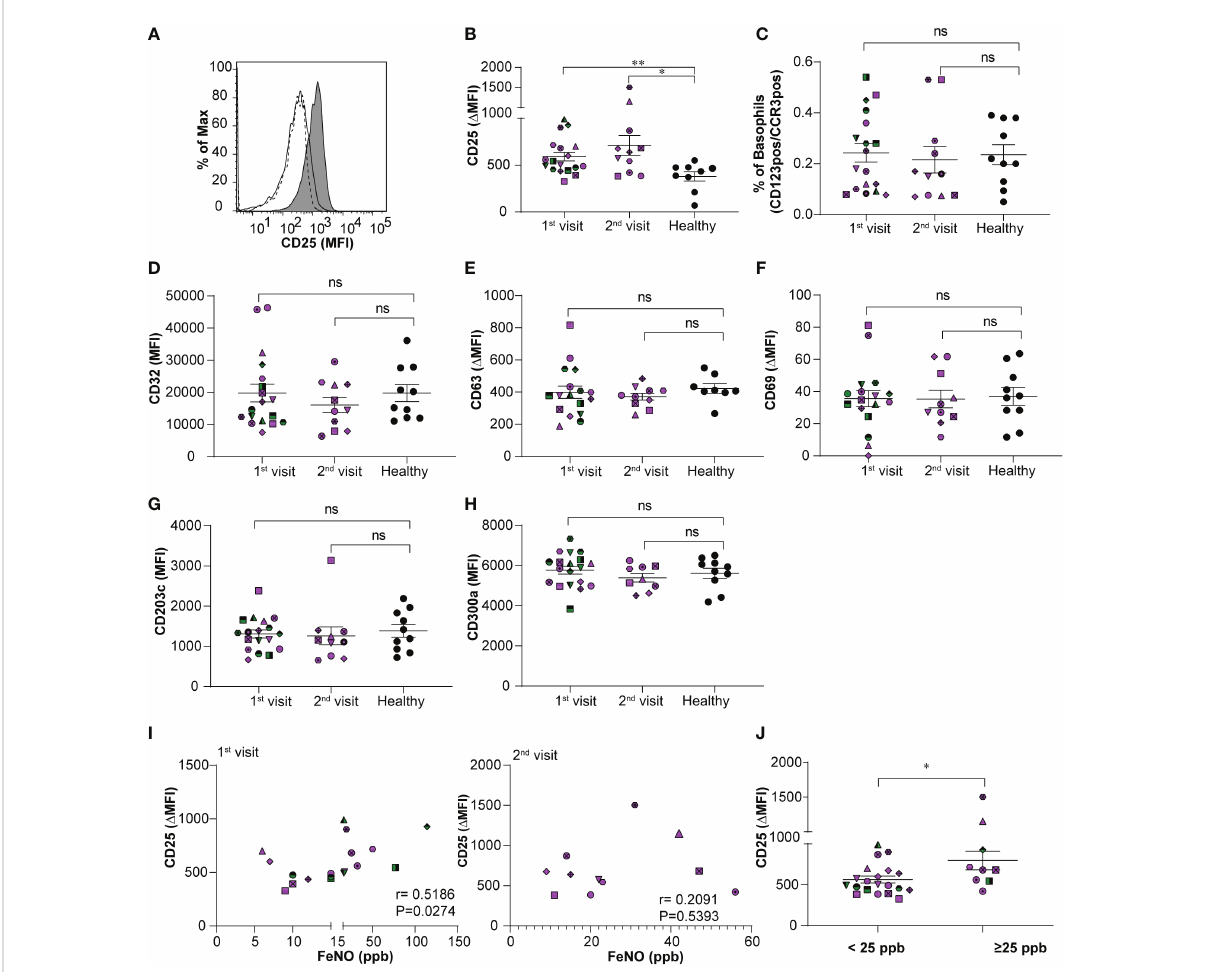
FIGURE 1 Relationship between expression levels of CD25 on basophils and FeNO levels in stable-mildly symptomatic allergic asthma patients. (A) Representative histogram showing CD25 expression level (MFI) on blood basophils in stable-mildly symptomatic allergic asthma patient (gray area) compared to healthy control (solid line) and FMO control (dotted line). (B, D-H) The expression levels of surface markers on blood basophils of stable-mildly symptomatic allergic asthma patients for the fi rst (n=18) and second visit (n ≤ 11) compared to healthy controls (n ≥ 9) measured by fl ow cytometry. Data are represented as mean ± SEM and reported as D MFI (MFI of test-MFI of FMO control) for CD25, CD63, CD69 and as MFI for CD32, CD203c and CD300a. Results were analyzed by two-tailed unpaired Mann-Whitney test.**P=0.0065, *P=0.0159, ns=non-signi fi cant (C) The relative percentage of blood basophils (dual positive for CD123 and CCR3) from stable-mildly symptomatic allergic asthma patients during their fi rst (n=18) and second (n=11) visits compared to healthy subjects (n=10) (I) Correlation between CD25 expression levels ( D MFI) and FeNO levels (ppb) in stable-mildly symptomatic allergic asthma patients of the fi rst (left, n=18) and second visit (right, n=11). Spearman`s rank test was used for correlation analysis. Spearman coef fi cient (r) and level of signi fi cance (P) are indicated within the graph. (J) Surface expression levels of CD25 ( D MFI) on blood basophils between <25 ppb (n=20) and ≥ 25 ppb FeNO level (n= 9) groups within stable- mildly symptomatic allergic asthma patients. Data are represented as mean ± SEM and analyzed using two-tailed unpaired Mann-Whitney test. *P<0.05. (B-J) Every patient is represented with speci fi c symbol, while healthy controls are shown in closed black symbols. Patients who had both 1 st and 2 nd visits are marked in purple and those who had only 1 st visit are marked in green color. MFI, median fl uorescence intensity; FMO, fl uorescence minus one; Healthy, healthy control